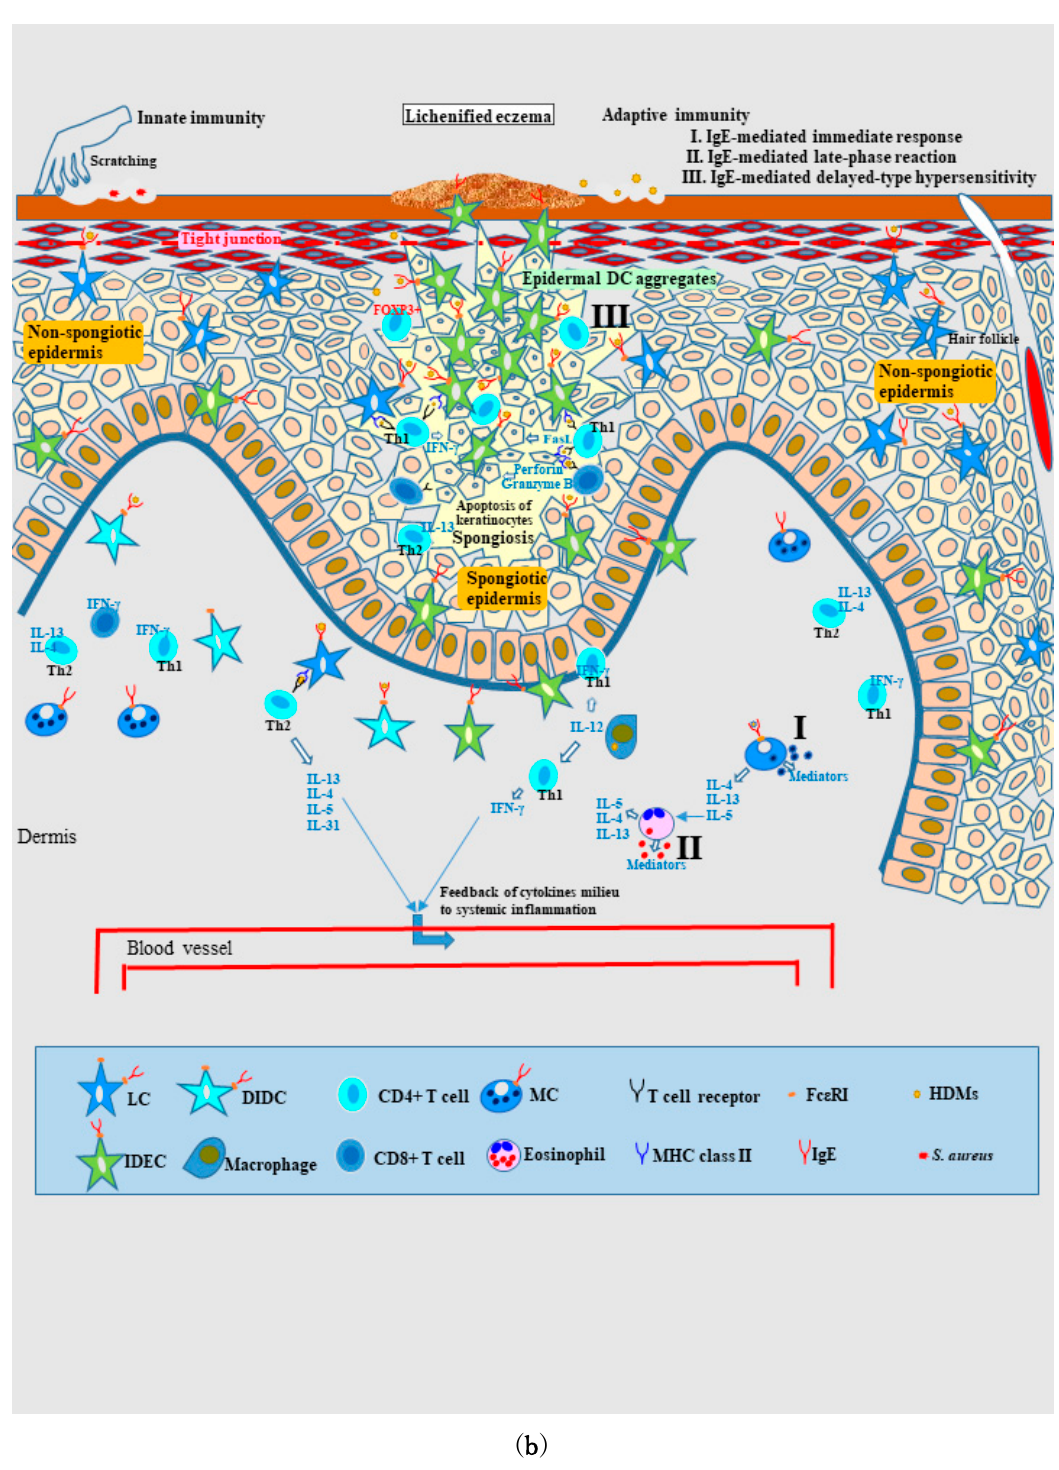
Figure 4. ( a ). Schematic illustration of non-lesioned skin and the positive-reaction site of atopy patch test in IgE-allergic AD. In non-lesioned skin, IgE-expressing LCs are regularly arranged in preparation for allergen/antigen invasion of the epidermis, and both Th2 (IL-4– or IL-13-expressing) and Th1 (INF- γ -expressing) cells and T cytotoxic (INF- γ -expressing CD8+) cells are increased among dermal infiltrating cells. IDECs are not found in the epidermis, and inflammatory DCs expressing IgE are almost undetectable in the dermis. Allergens such as HDMs are rarely observed in the dermis and epidermis by histopathological analysis. In the APT-positive reaction site for allergens (e.g., HDMs and pollens), spongiotic dermatitis is observed as a characteristic finding. Therefore, this characteristic has been used in pathological analysis as a prototype of acute AD lesions that reflect IgE-mediated delayed-type hypersensitivity. Considering the APT for HDM antigens in